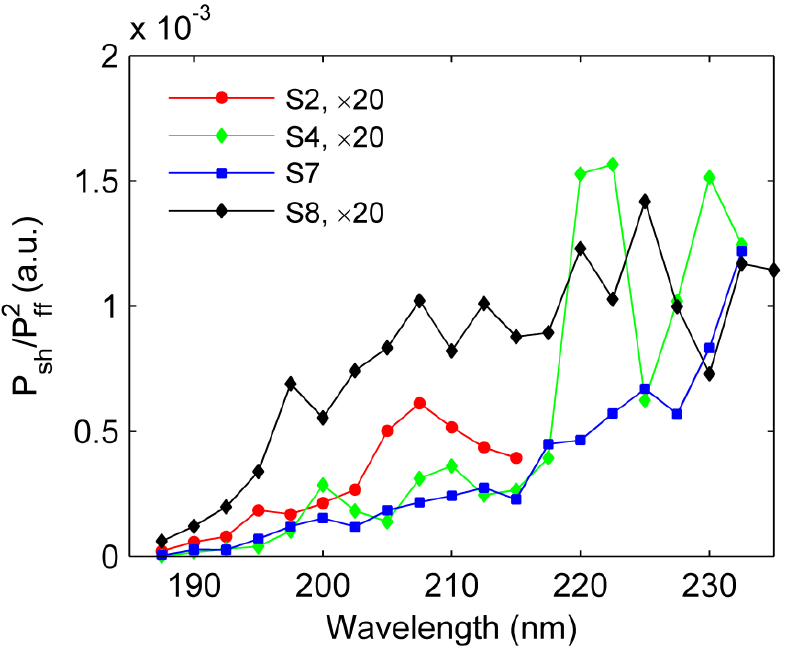
Figure 6. DUV tuning curves for several samples (S2, S4, S7, S8) obtained in separate growth experiments. DUV power is normalized to the square of the power of the fundamental beam.